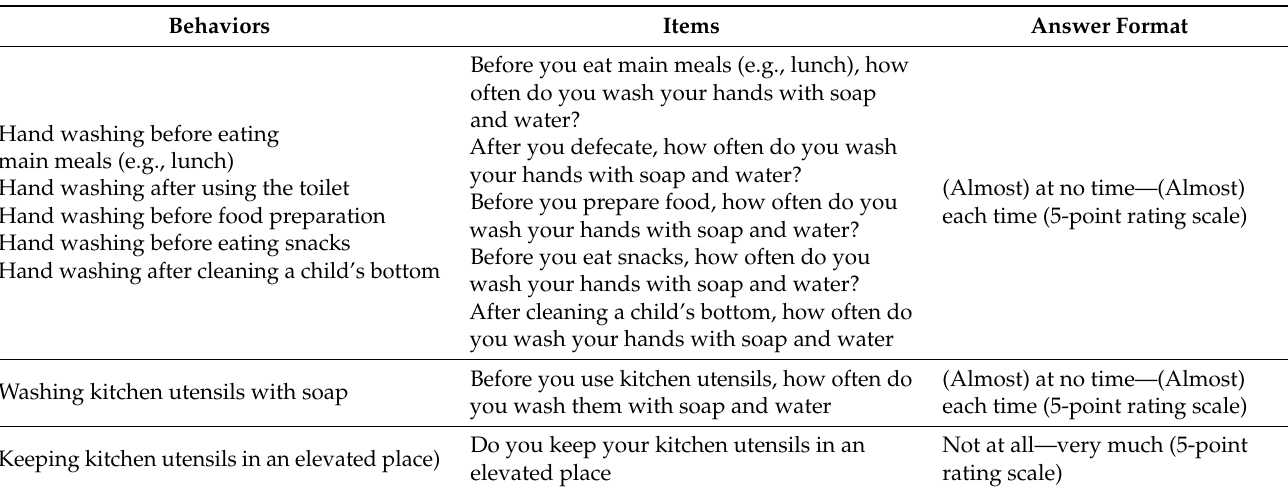
Table 1. Key behavior